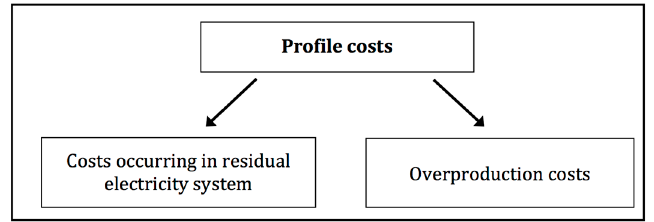
Figure 4. Two components of profile costs. Sources: Based on [14,51].